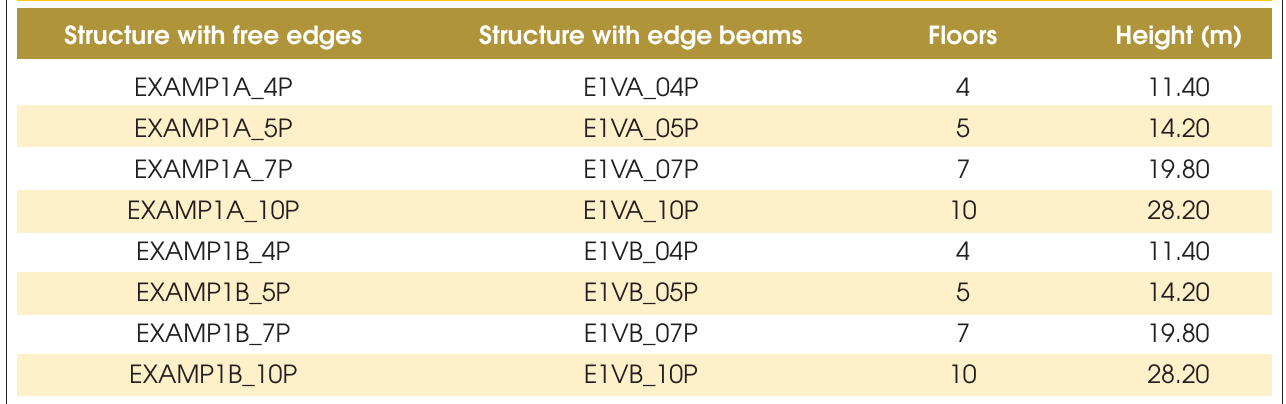
as 3.00 m. Table 2 lists the vertical characteristics of each